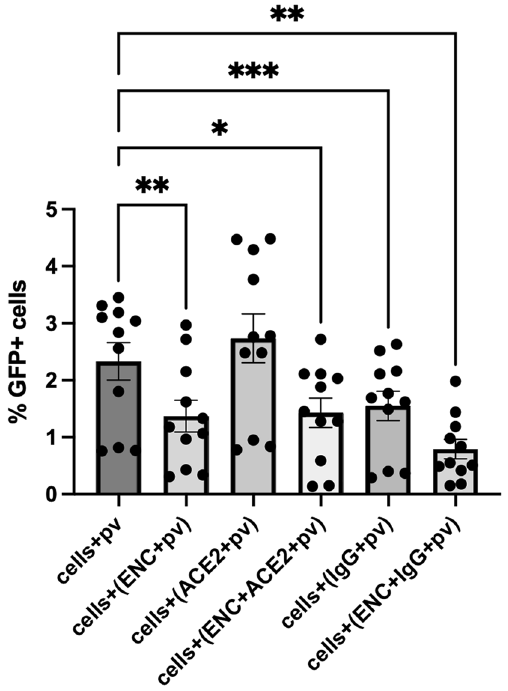
Figure 7. NaCl was critical for crosslinking and capture of virus in ENC. 293T-hsACE2 cells were inoculated with SARS-CoV-2 pseudovirus (pv) with a GFP reporter in conditions with and without endospermic nanocellulose (ENC) and molecular lures (ACE2 or anti-SARS-CoV-2 S IgG (IgG)) and incubated for 3 days, as in previous experiments except that NaCl was replaced with culture medium in preparation of reagents. Cells were harvested for flow cytometry analysis and % of GFP infected cells was displayed for each condition (n = 16, * p < 0.05, ** p < 0.01, *** p < 0.001, ANOVA, mean ± SEM). ENC reduced but did not completely inhibit infection as in experiments where ENC was crosslinked by